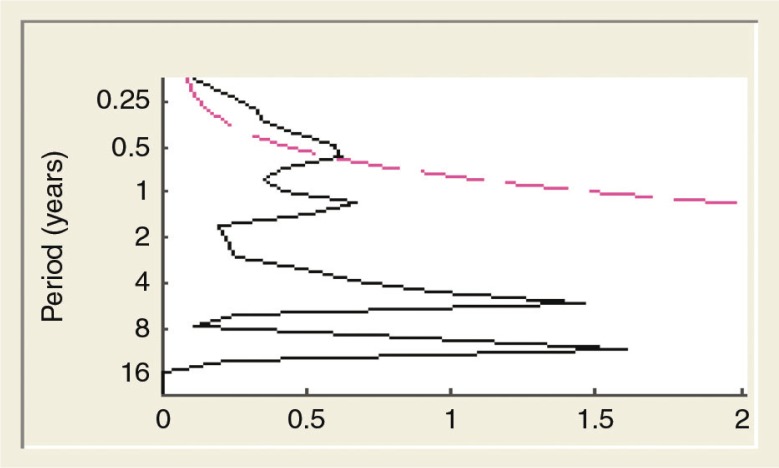
The statistical significance of the flu cycle. The pink line is the area of statistical significance: . The back line displays the seasonality of ILI cases: . Y-axis displayed period of time (years) for the seasonality of ILI reiterated. X-axis displayed the peak of epidemic after a cycle reiterated. This figure shows four peaks of the ILI corresponding to the period of time of the ILI cycle. The ILI cycle of 1 year once, 4 years once, and 8 years once are very clear but only the cyclic pattern twice a year was significantly statistic (the area lies in the pink line).